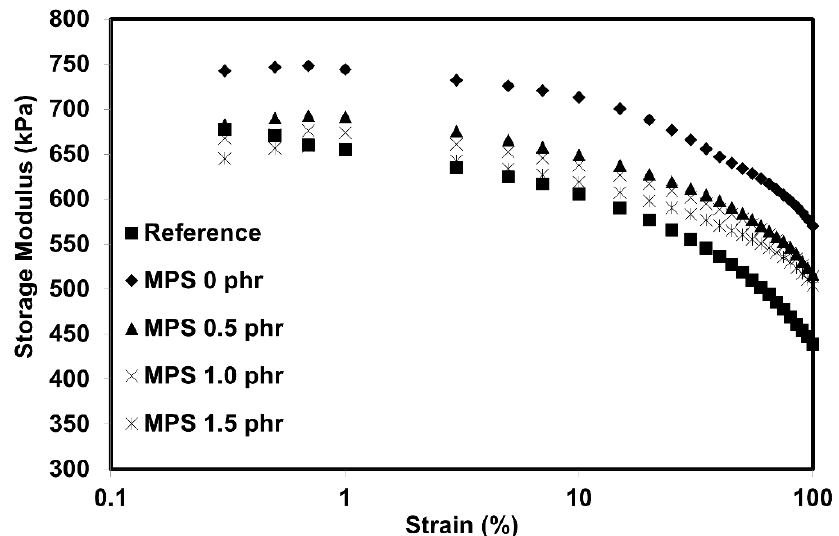
Figure 8. The storage modulus ( G’ ) of NR/HNT composites in the presence of MNR/MPS as a dual compatibilizer.